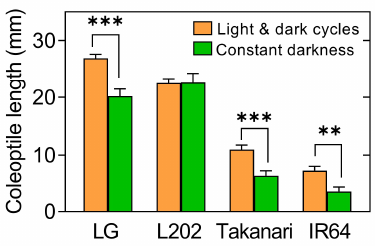
Figure 2. The influence of light on coleoptile elongation under oxygen deprivation in rice varieties, with and without anaerobic germination tolerance. Seeds were germinated under oxygen depriva- tion for 5 days under 12 h light and 12 h dark cycles or under constant darkness. Data represent means ± SE ( n = 20). Asterisks indicate a significant difference between the two growth conditions (** p < 0.01, *** p < 0.001; t -test).